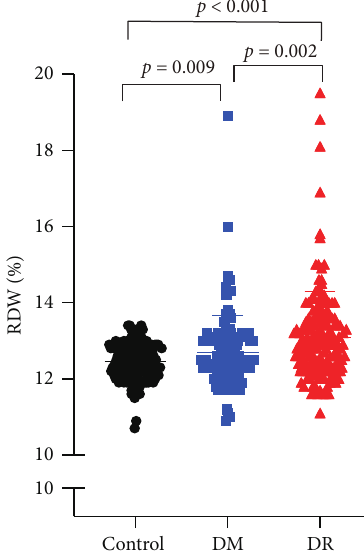
Figure 2: Distribution of RDW among the DR, DM, and control groups. Table 2: Comparison of RDW by age and gender in DR, DM, and control